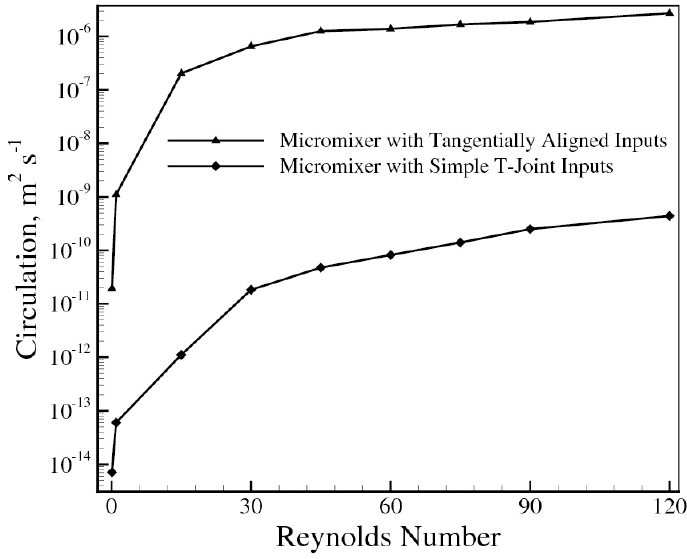
Figure 10. Variations of normalized circulation at the exit of micromixer with Reynolds number.